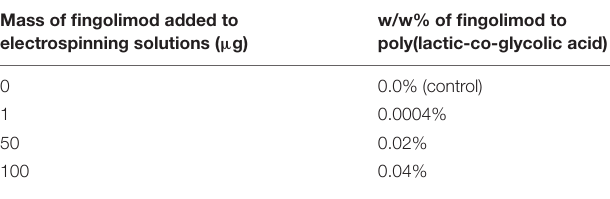
TABLE 1 | Fiber groups fabricated for the